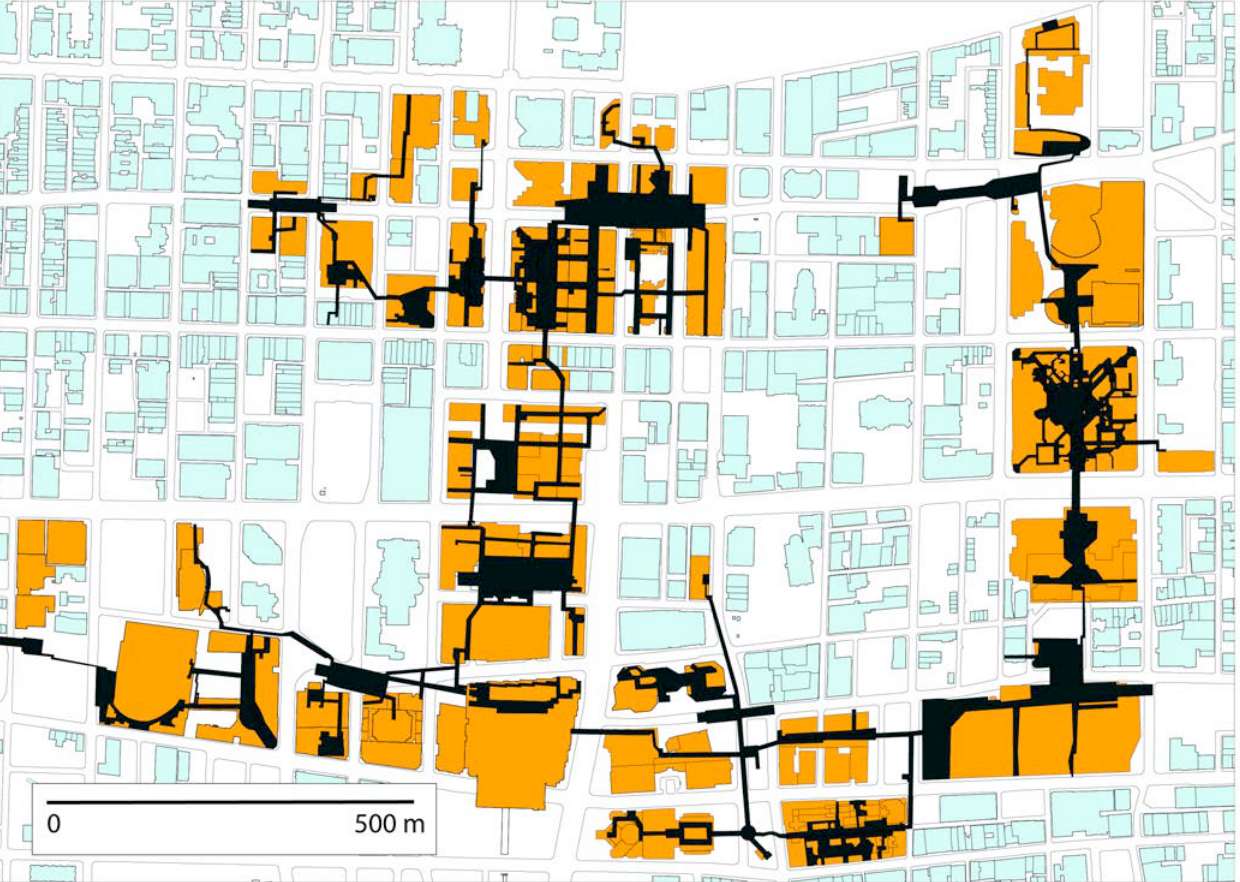
Figure 1. The Underground system of Montreal connects two main axes of development in the core area. The Underground is shown at one level in dark grey, with all buildings directly connected to the Underground in